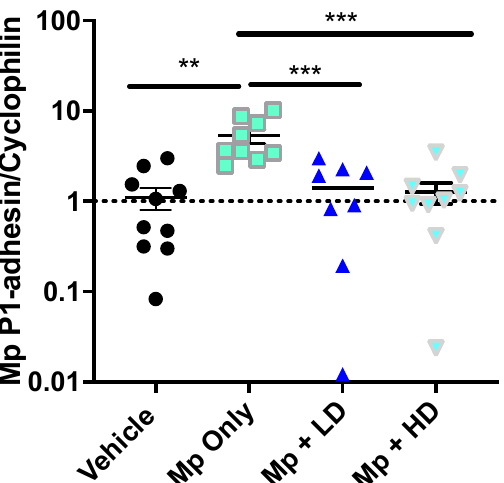
Figure 2. The effect of Ang-(1–7) on Mycoplasma pneumoniae burden in lung tissue. Mp burden was determined in lung tissue by RT-PCR for Mp-specific P1-adhesin gene expression relative to housekeeper, Cyclophilin . Data are expressed in mean ± SEM. n = 8–10 mice/group, two independent experiments combined. ** p < 0.01, *** p < 0.001 by one-way ANOVA for multiple comparisons.